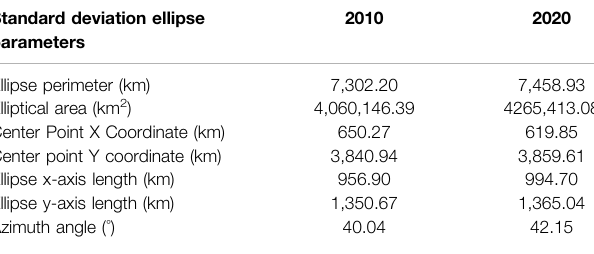
TABLE 4 | The parameters of standard deviation ellipse in China during 2010 –